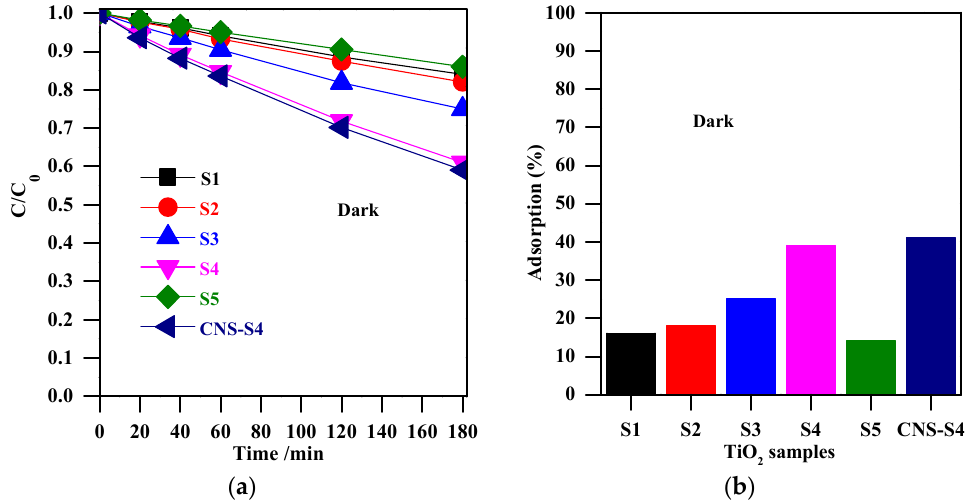
Figure 5. ( a ) change of the MC-LR concentration during stirring in the dark; ( b ) adsorption (%) for MC-LR on the surface of S1, S2, S3, S4, S5, and CNS-S4. Catalyst loading, 0.4 g L − 1 ; MC-LR dose, 10 mg L − 1 ; pH, 4; T, 25 °C; reaction volume 40 mL.